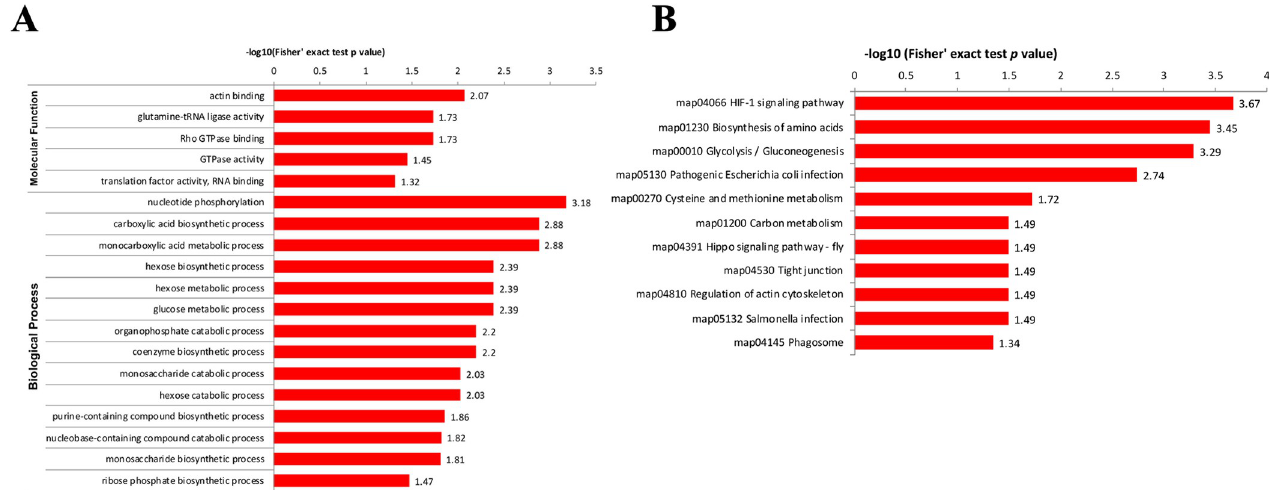
Fig 7. Functional enrichment analysis of the differential malonylated proteins in PRU vs. VEG strains. (A) GO analysis and B) KEGG pathway analysis of the differentially malonylated proteins.